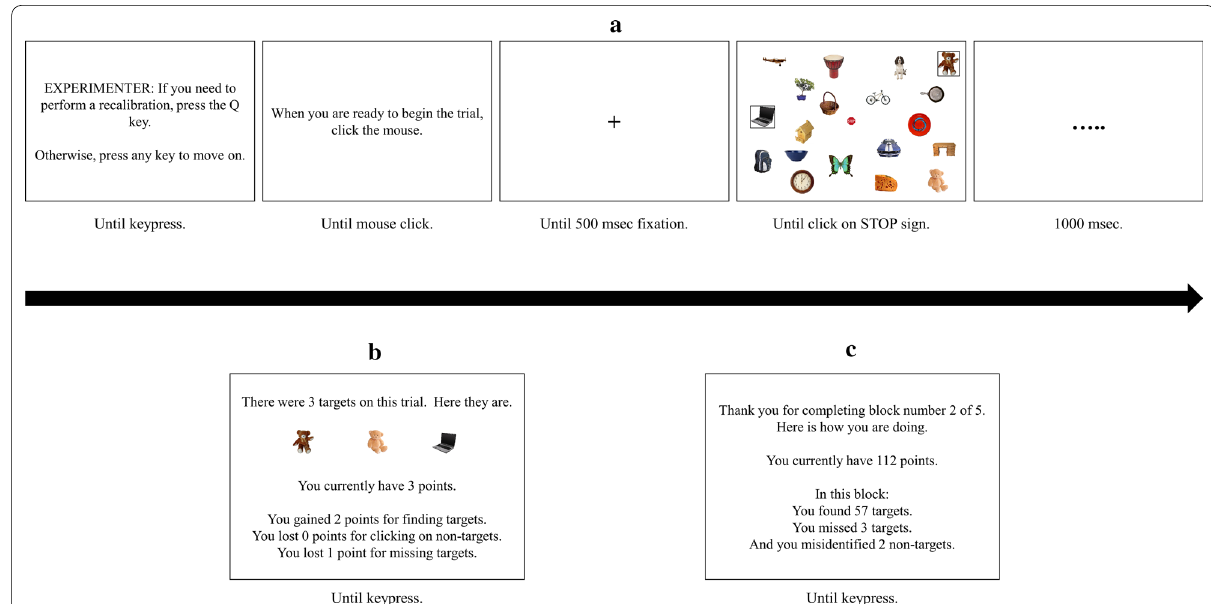
Fig. 2 a Progression of events during a visual search trial. Borders drawn around objects indicate the participant selected them as targets. Note that the display is not drawn to scale, and 32 items were displayed on all trials. b The feedback that followed each practice trial. No feedback was present following experimental trials. c The feedback that followed each block of experimental